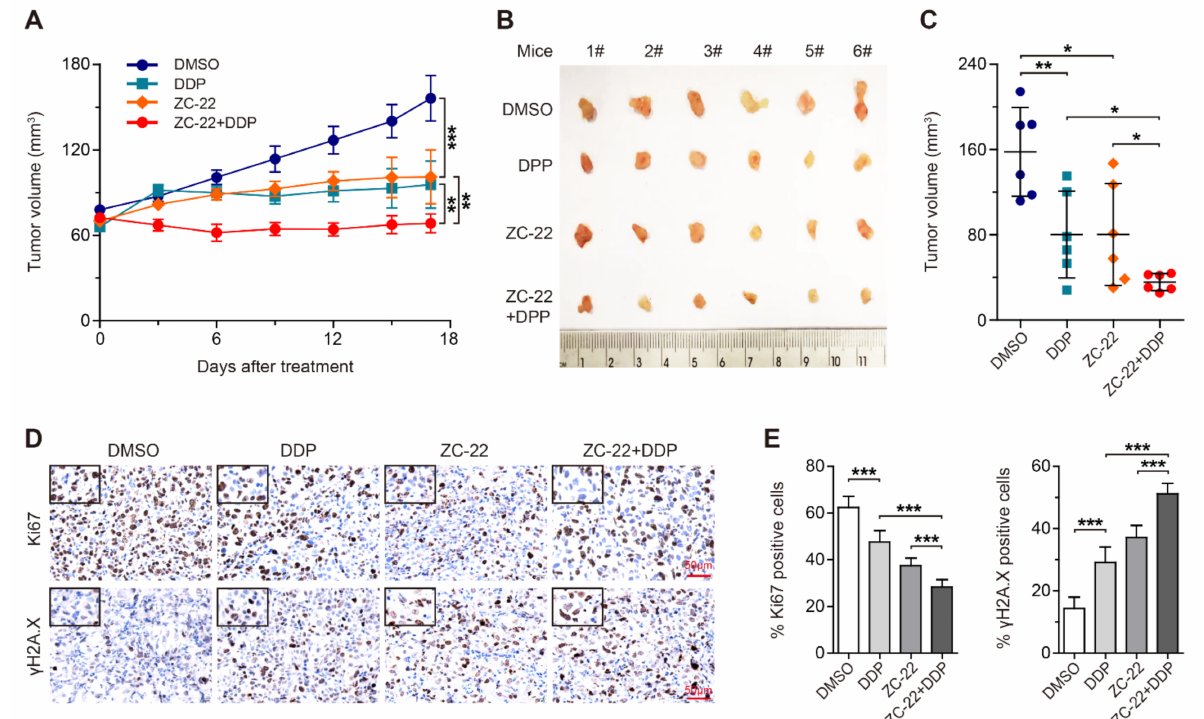
Figure 7. ZC-22 increases the efficacy of cisplatin treatment in ovarian cancer cells in vivo. Female NOD-SCID mice were injected subcutaneously with 8 × 10 6 of OVCAR5 cells and treated ip daily with 1.5 mg/kg of cisplatin (DDP) or 50 mg/kg of ZC-22 alone or together (ZC-22 + DDP) starting on day 10 after injection of cells when tumors were 50–70 mm 3 in size. Tumor volumes were measured every 2–3 days. ( A ) Growth curve of the OVCAR5 xenograft tumors with indicated treatment. Values are means ± SEM, n = 6. ( B , C ) Pictures ( B ) and quantification of the size ( C ) of the OVCAR5 xenograft tumors at the end points. Values are means ± SD, n = 6. ( D , E ) Representative pictures ( D ) and quantification of percentage ( E ) of Ki67 and γ H2A.X-positive cells in immunohistochemical staining of the OVCAR5 xenograft tumor tissues. Values are means ± SEM, n = 6. * p < 0.05, ** p < 0.01, and *** p < 0.001 in an unpaired t